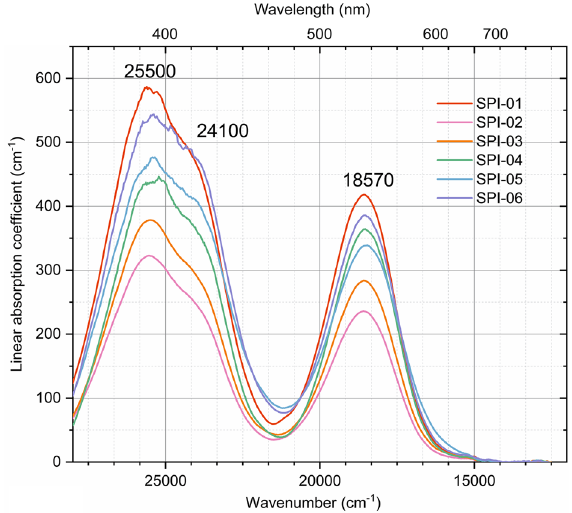
Figure 1. Optical absorption spectra of the present